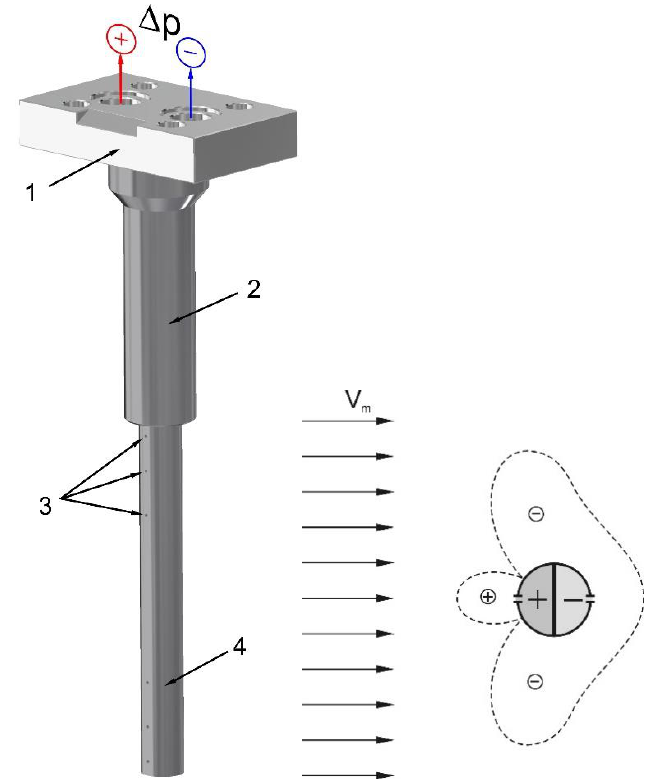
Figure 1. Averaging Pitot tube: 1-head, 2-cylindrical part (mounted in choke), 3—impulse holes, 4—flow sensor.